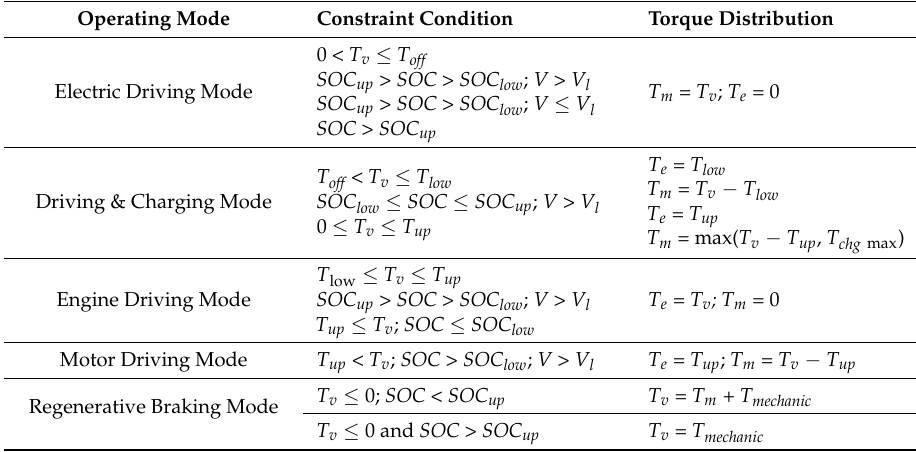
Table 1. Revised rule-based energy management strategy (EMS).